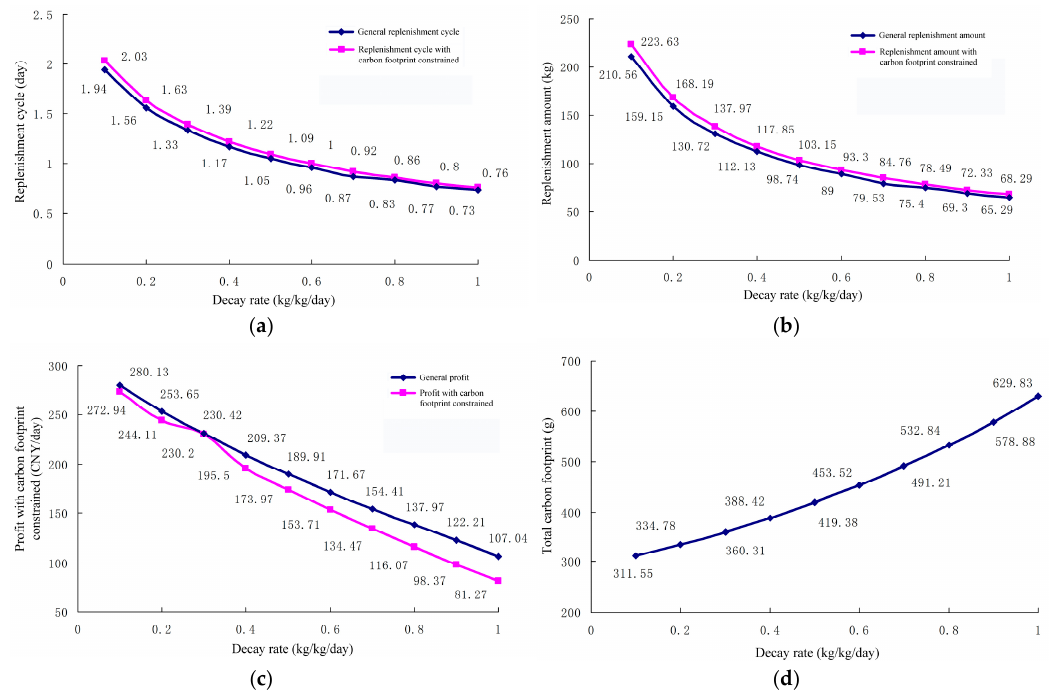
Figure 4. Influence of the decay rate: ( a ) the curve of the replenishment cycle; ( b ) the curve of the replenishment amount; ( c ) the curve of the profit with carbon footprint constraint; ( d ) the curve of the total carbon footprint.